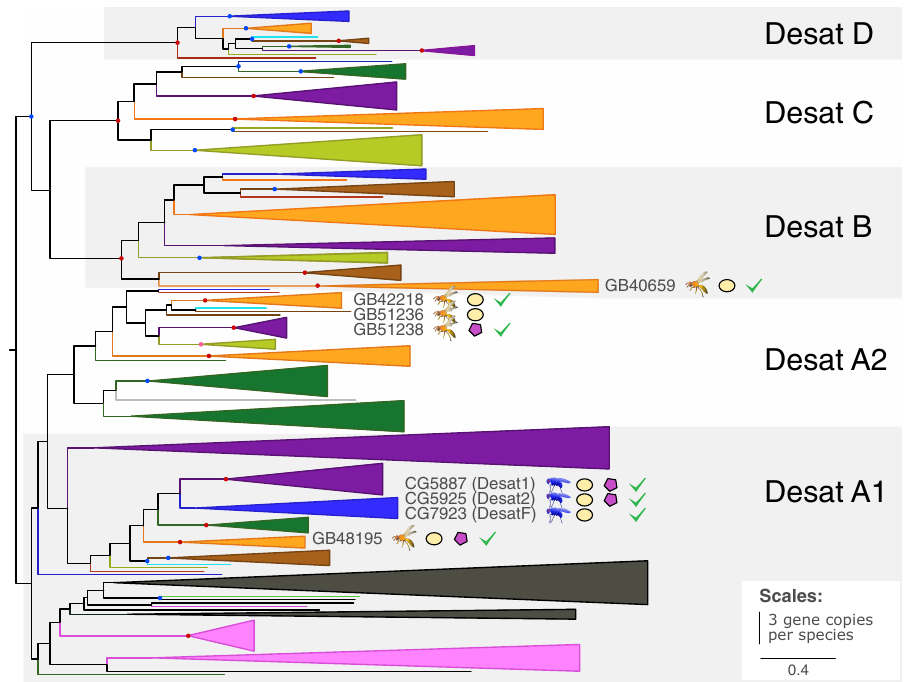
Fig. 3 Gene tree of fatty acid desaturases from 37 species Euarthropoda showing copy numbers and involvement of genes in CHC biosynthesis. Color coding and symbols are as in the legend of Fig. 2.